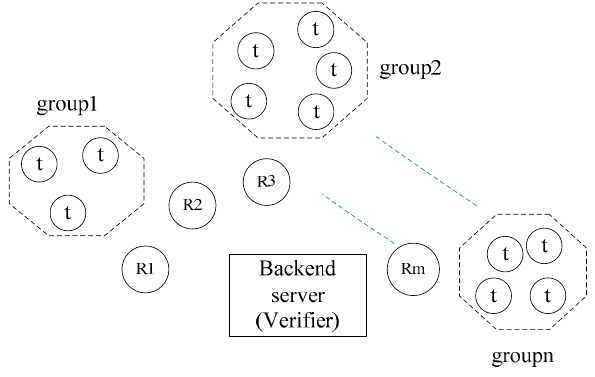
Figure 1. The components of a Radio Frequency Identification (RFID) system (Rx: reader, t: tag).